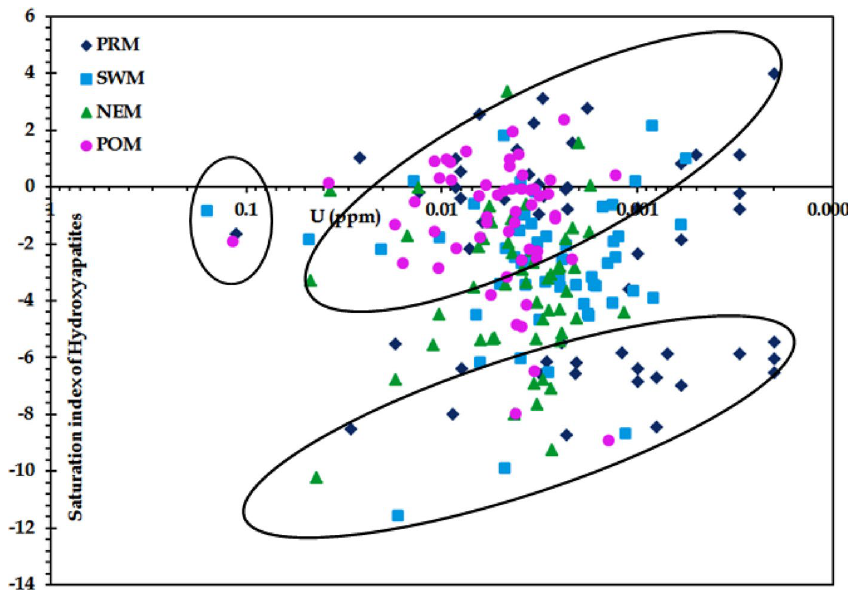
Fig. 17 Variation of Saturation index of Hydroxyapatite with U conentration in